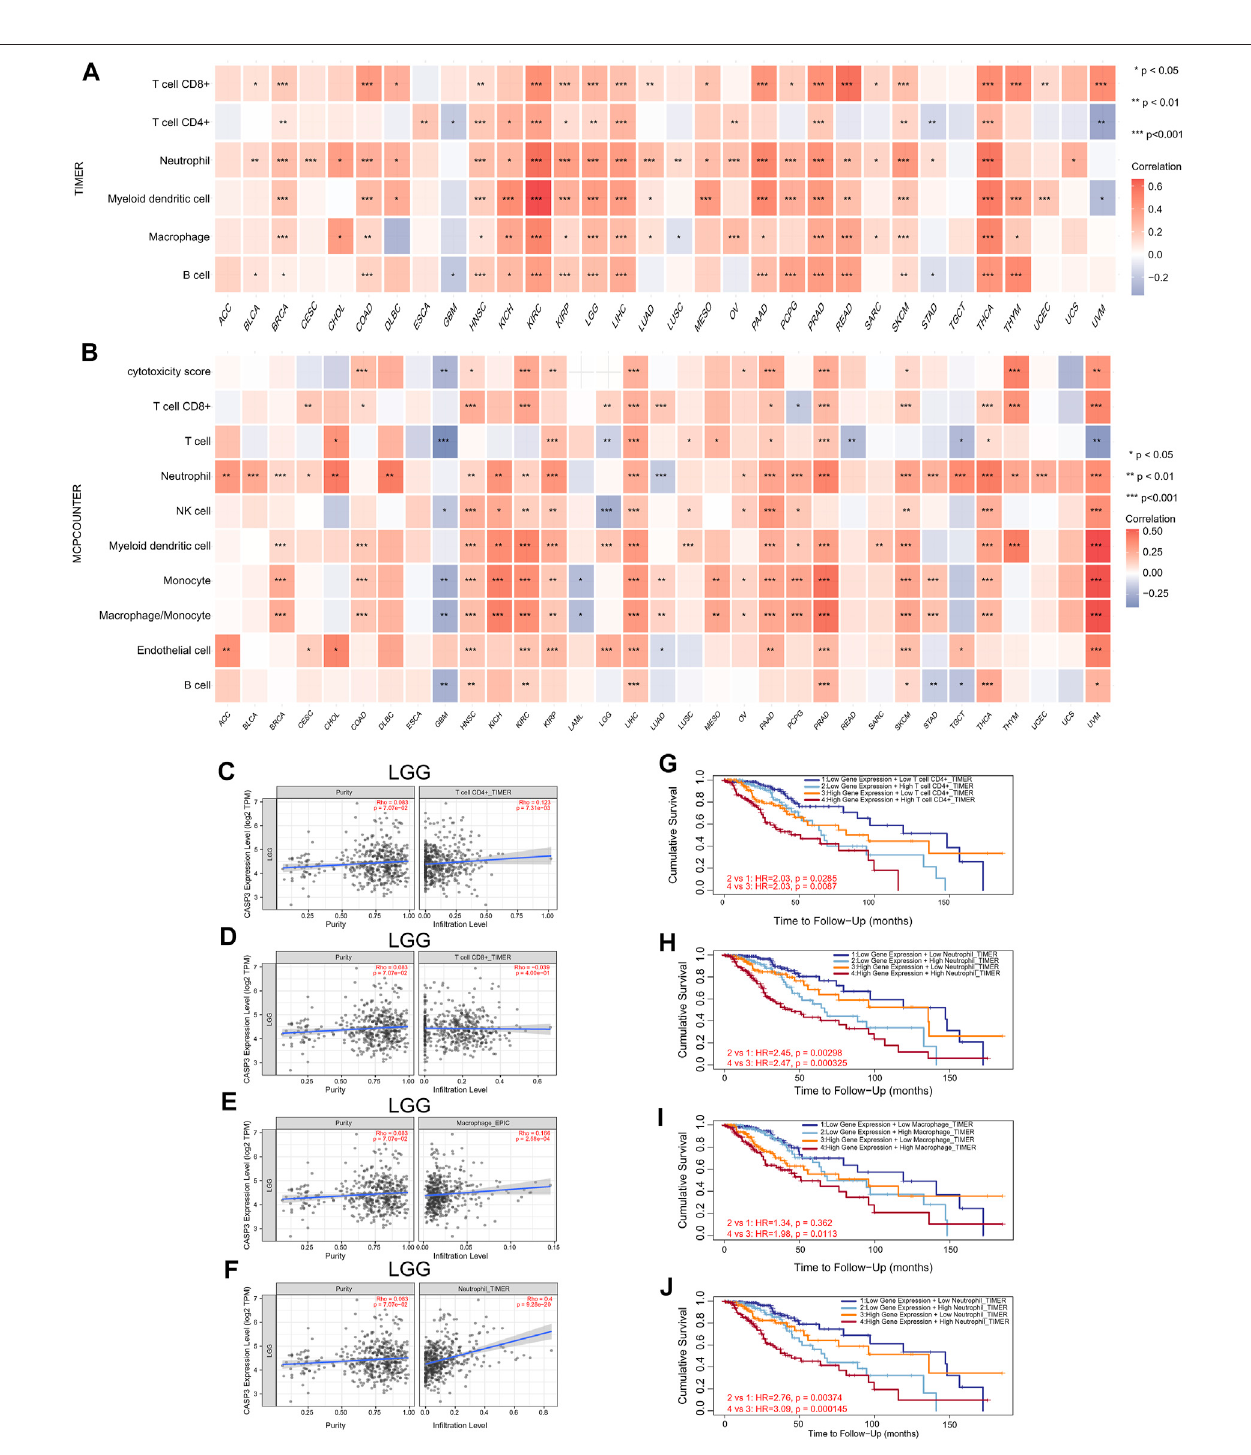
FIGURE 9 | Relationship between the expression of CASP3 and tumour immune cell in fi ltration. (A) Correlation between expression of CASP3 based on TIMER algorithmandtumourimmunecellin fi ltration.* p < 0.05,** p < 0.01,*** p < 0.001. (B) Correlationbetweentheexpressionof CASP3 basedonMCP-counteralgorithmand tumourimmunecellin fi ltration.* p < 0.05,** p < 0.01,*** p < 0.001. (C – F) Relationshipbetweentheexpressionof CASP3 inLGGandthein fi ltrationofimmunecells. (G – J) Kaplan-Meier survival analysis of CASP3 expression and the relationship between immune in fi ltration and OS of LGG.